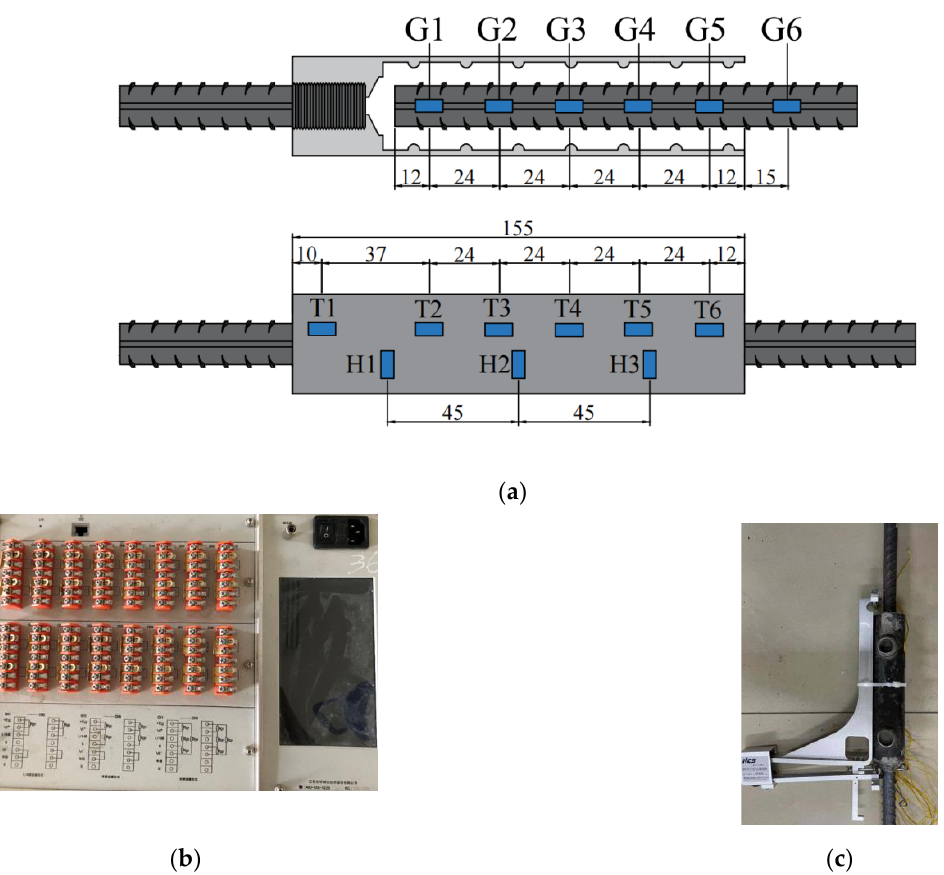
Figure 10. Measurement information. ( a ) Position of strain measuring point. ( b ) Automatic data acquisition system. ( c ) Extensometer arrangement.